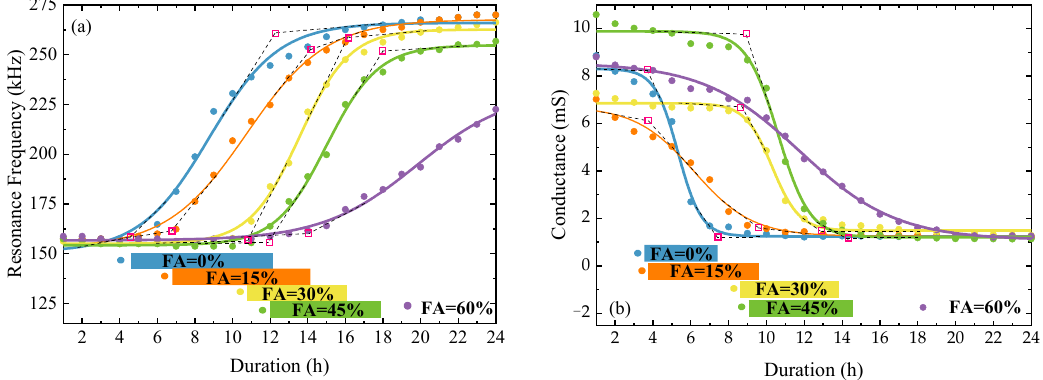
Figure 7. Resonance frequencies ( a ) and amplitudes ( b ) for SCC specimens with different FA replacement ratios during curing.